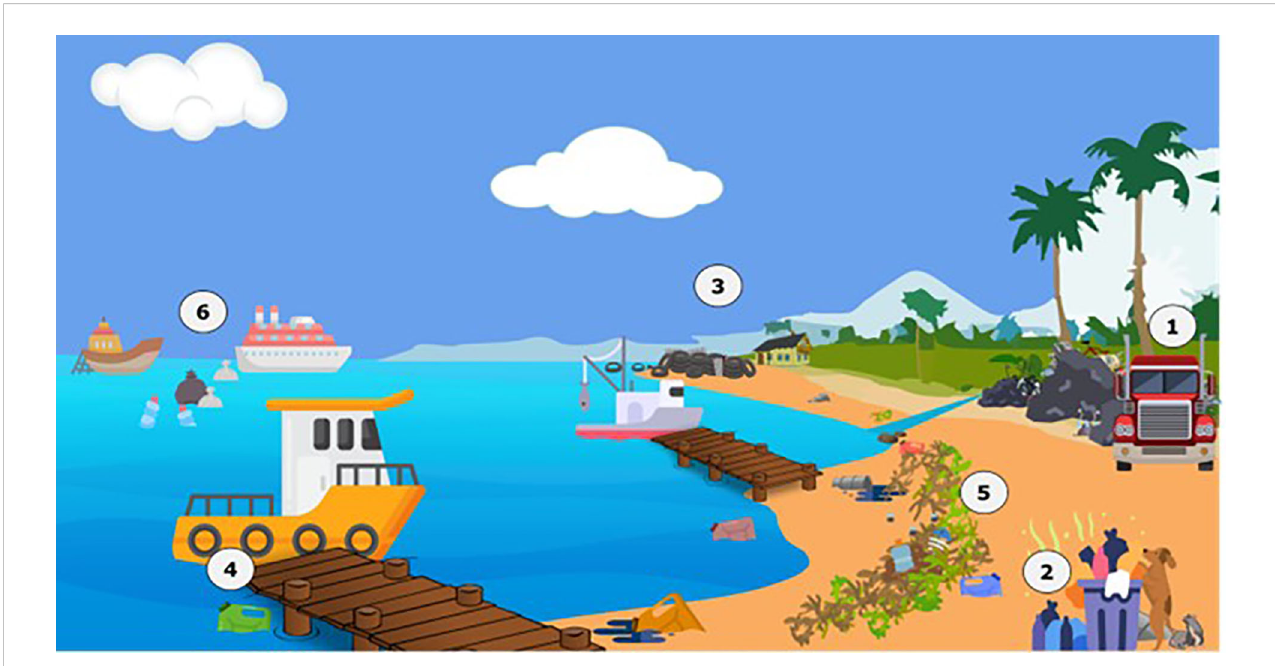
FIGURE 4 An illustration of marine litter issues based on the observations shared by participants (for country-speci fi c details refer to supplementary information). Some of the land to sea experiences are linked to solid waste management issues, including 1. illegal dumping on or near coast and rivers, and 2. overwhelmed trash cans (also tied to insuf fi cient trash cans and inadequate collection efforts) resulting in inappropriate disposal of trash by the public, and the encouragement of stray and wild animals to ‘ rummage ’ and spread trash. Usually, over fi lled trash cans can be observed near drainage systems. 3. The haphazard use of old tires (among other debris) to serve as coastal barriers because of sea level rise and consequent erosions and fl ooding. 4. Inappropriate disposal of engine oil bottles by fi shermen. Ocean based experiences included 5. Debris entrapped in Sargassum , whether the debris is transboundary or from the mainland or both, remains to be investigated. 6. Illegal dumping and discharges by ships.